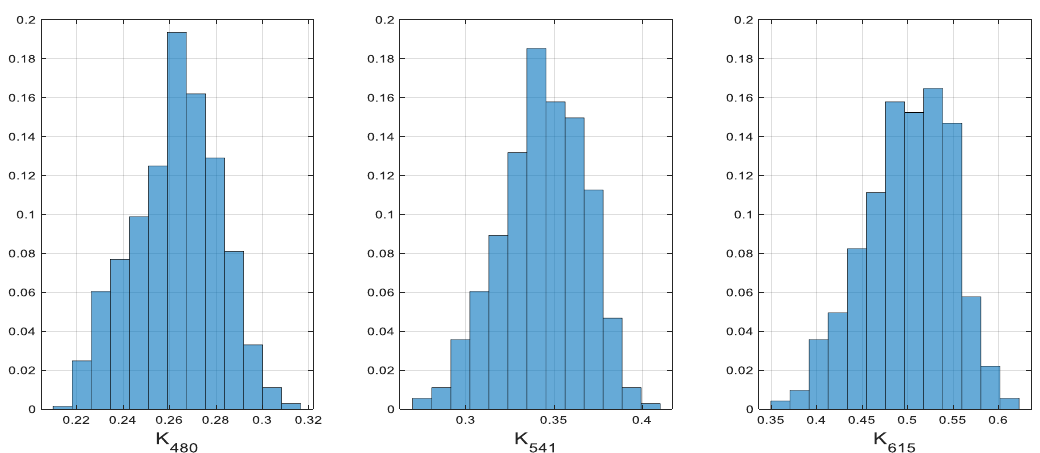
Figure 6. Probability density function of the calibration factor for each channel at its effective wavelength: 480 nm, 541 nm and 615 nm for the blue, green and red channels, respectively.